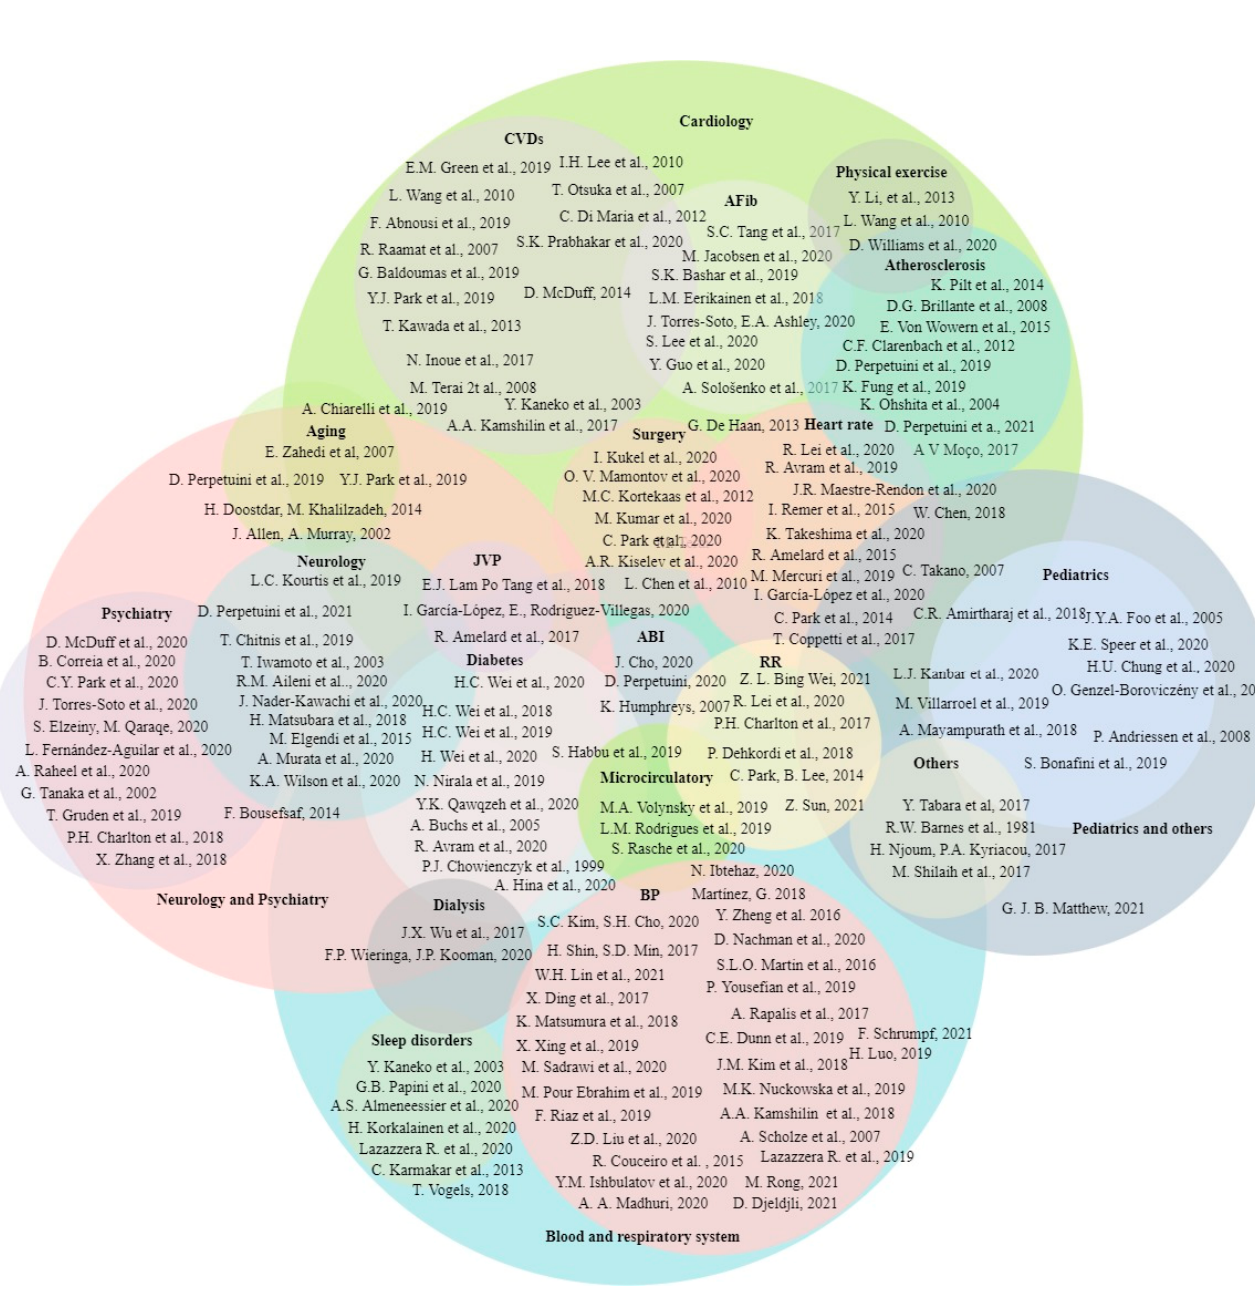
Figure 3. Venn diagram representing an overview of the PPG healthcare applications . Figure 6. Venn diagram representing an overview of the PPG healthcare applications